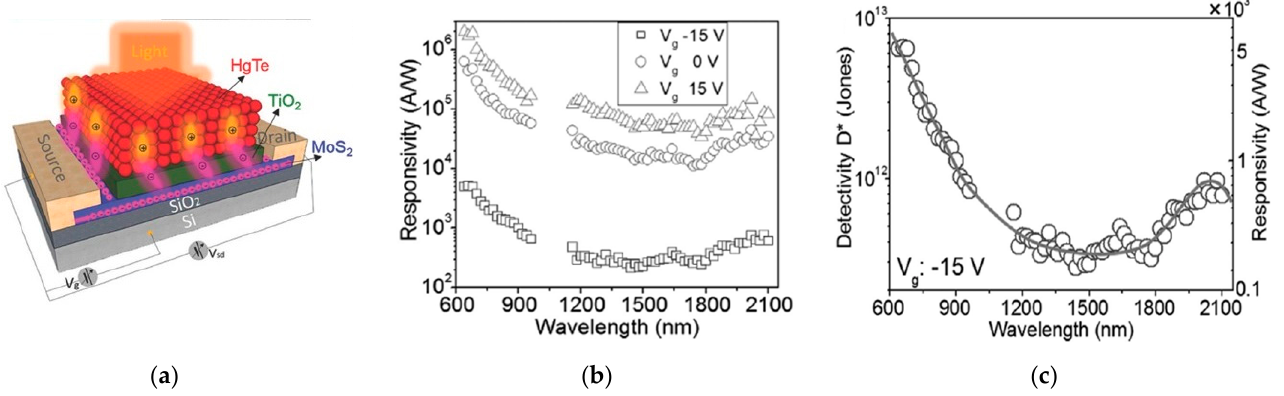
Figure 14. ( a ) Photodetector based on MoS 2 + HgTe; ( b , c ): responsivity and detectivity values over the vis-IR spectral range, respectively, for the same phototransistor. Reprinted with permission from ref. [35]. © 2017, John Wiley and Sons.